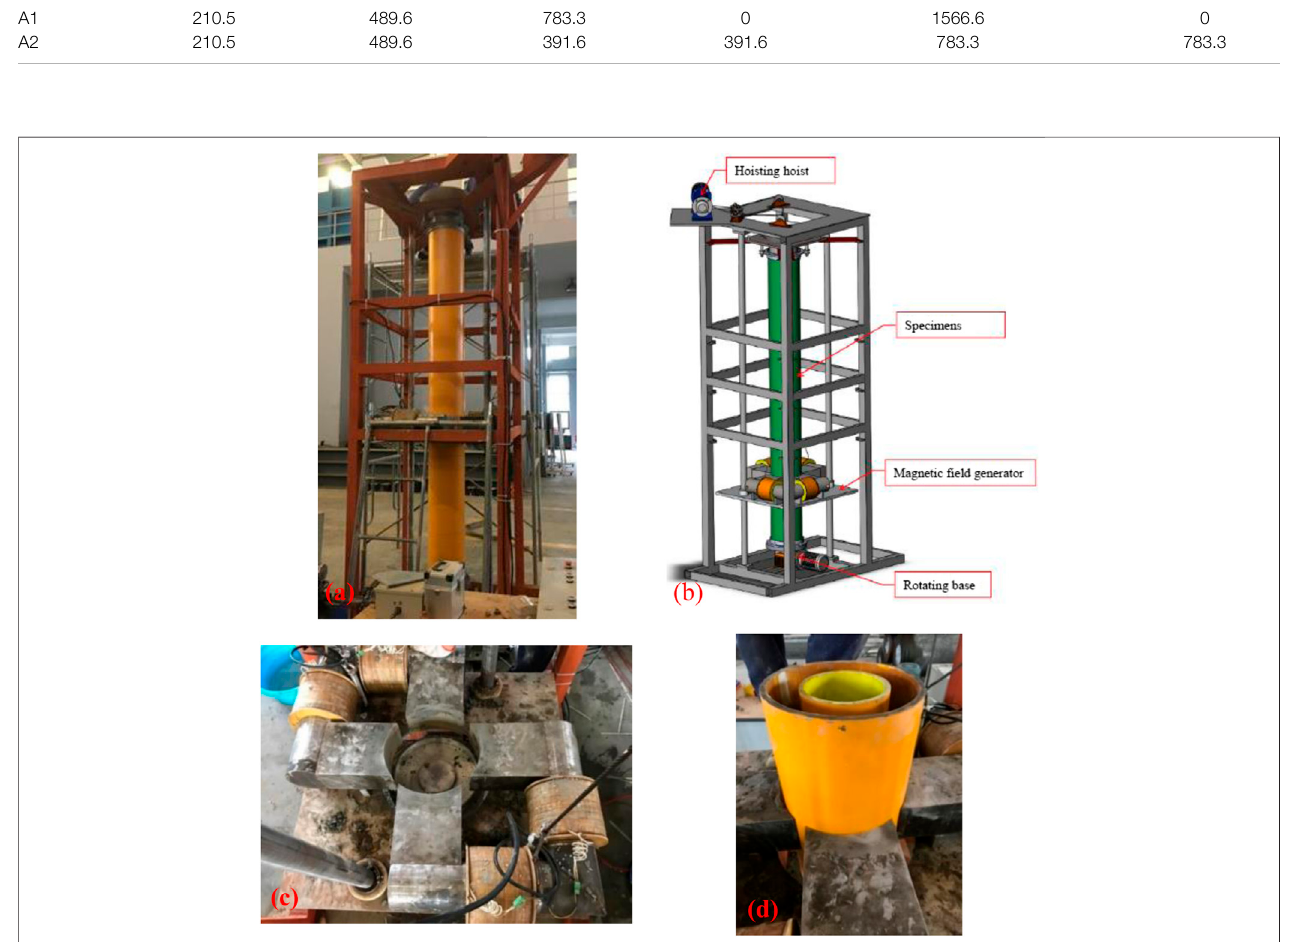
FIGURE 1 | Magnetic vibration device and four solenoid coils.